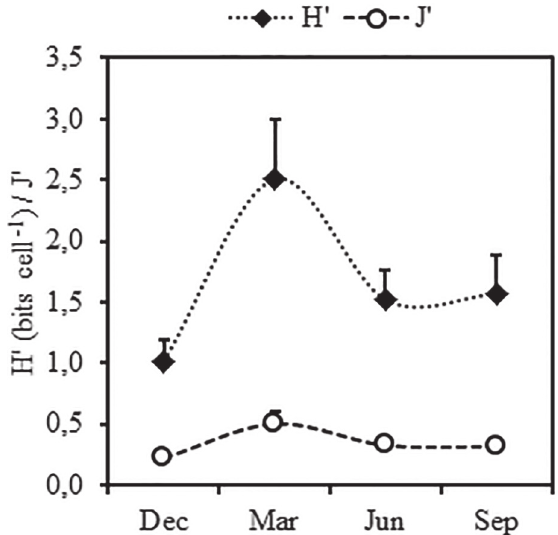
Figure 7 - Monthly average (±SD) of diversity indexes (H’) and evenness (J’) at Ajuruteua beach, Bragança,